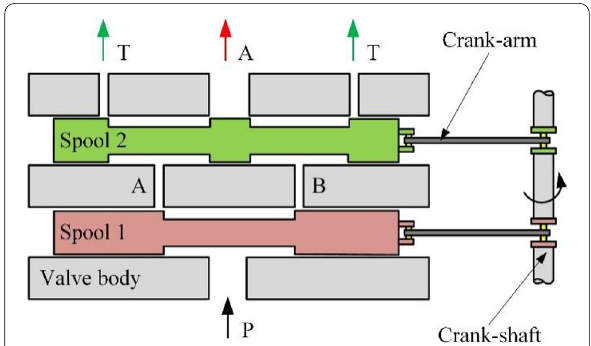
Figure 10 Crank-slider spool valve proposed by Koktavy et